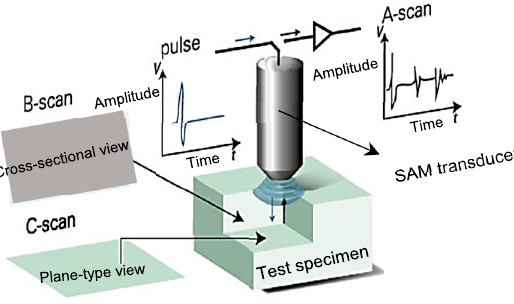
Figure 7. Schematic picture of three scan modes of SAM method (Courtesy of PVA TePla ® Company, Wettenberg, Germany).